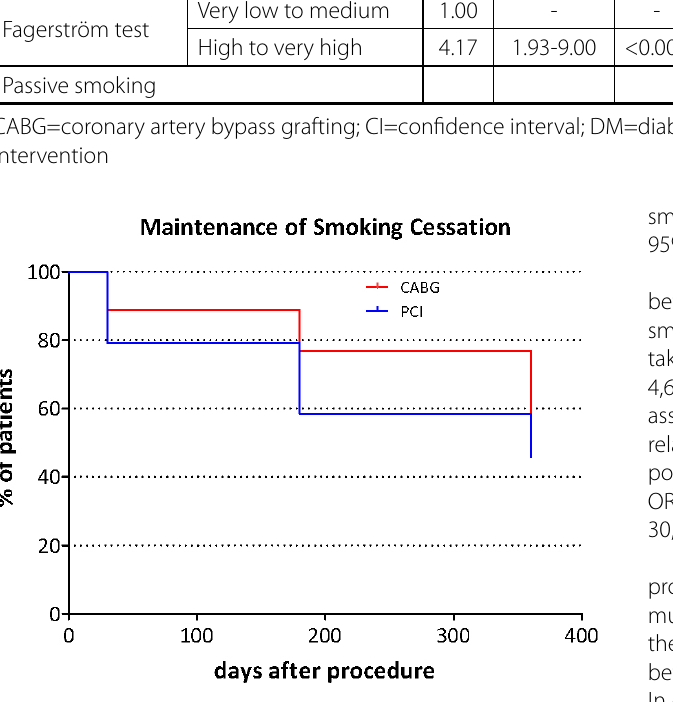
Fig. 1 - Kaplan-Meier curves for the maintenance of smoking cessation (log-rank test, P=0.238). CABG=coronary artery bypass grafting; PCI=percutaneous coronary